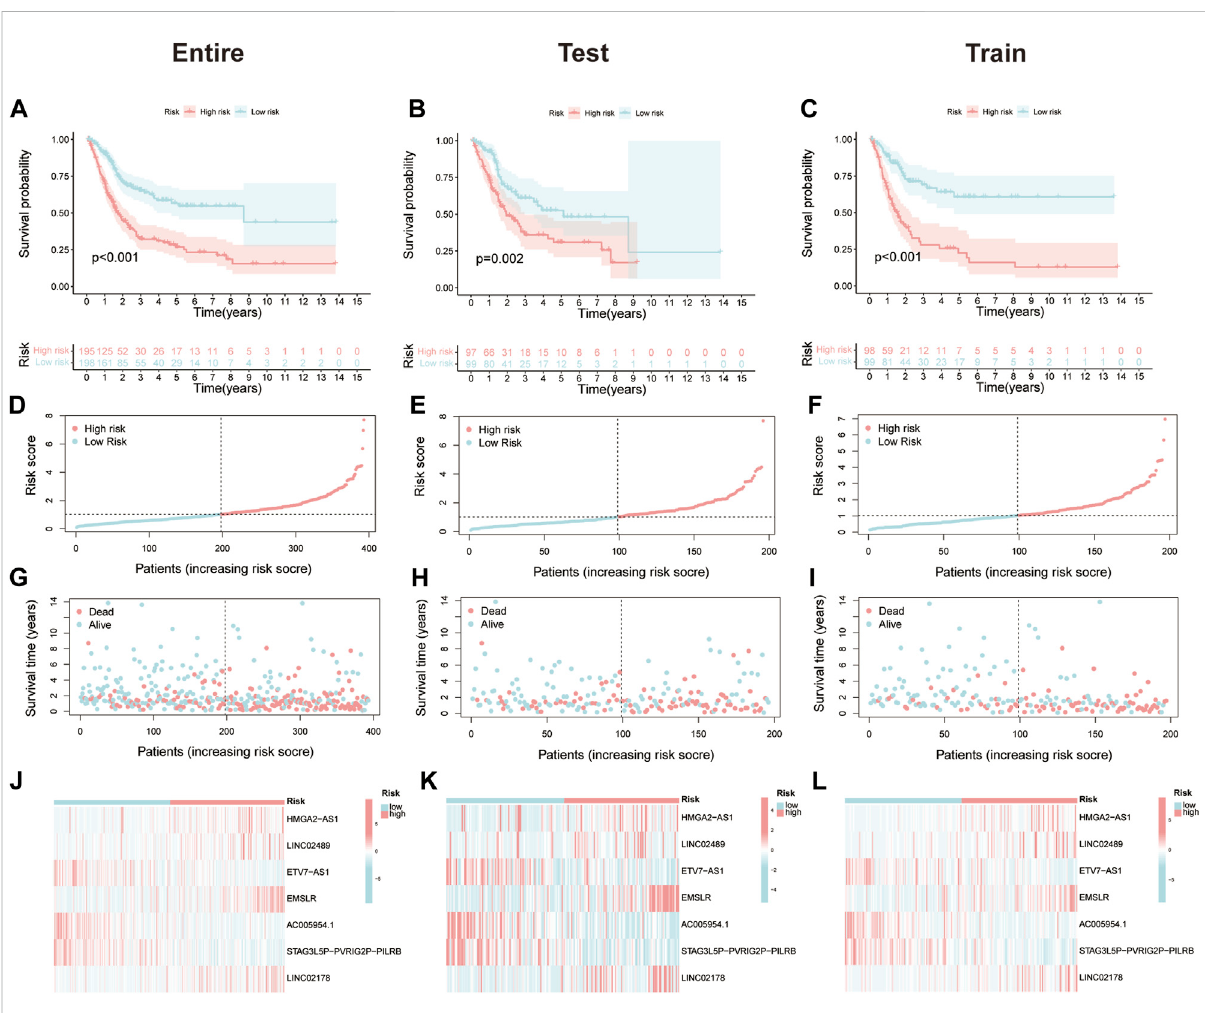
FIGURE 3 Prognostic value of the necroptosis-related risk model. (A – C) Kaplan – Meier survival curves of overall survival (OS) between high- and low-risk groups in the entire, test, and train cohort. (D – F) The distribution of risk score among muscle-invasive bladder cancer (MIBC) patients in the entire, test, and train cohort. (G – I) Exhibition of survival time and status between high- and low-risk groups in the entire, test, and train cohort. (J – L) The heat map of seven prognostic necroptosis-related lncRNAs (NLRs) expression in the entire, test, and train